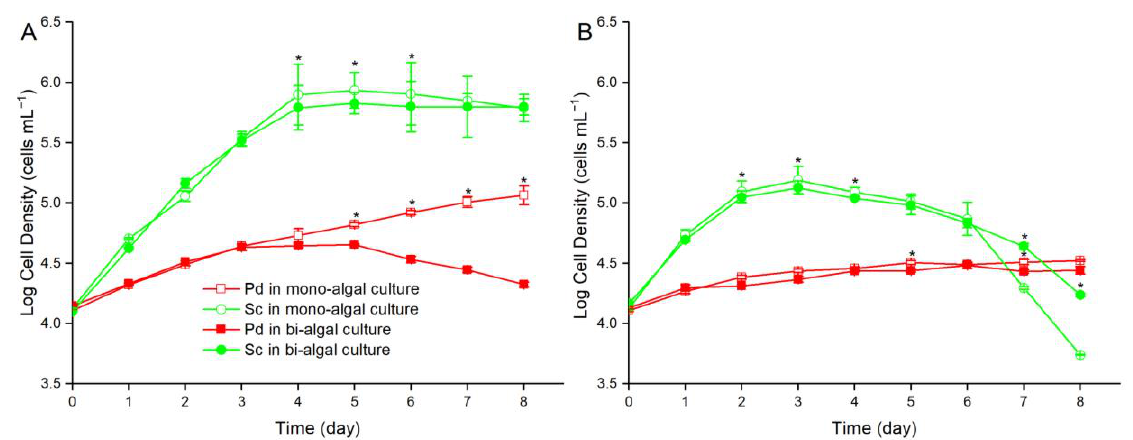
Table 1. Estimates of model parameters for the mono- and bi-algal cultures of S. costatum , P. don- ghaiense , and K. mikimotoi under P-sufficient conditions.